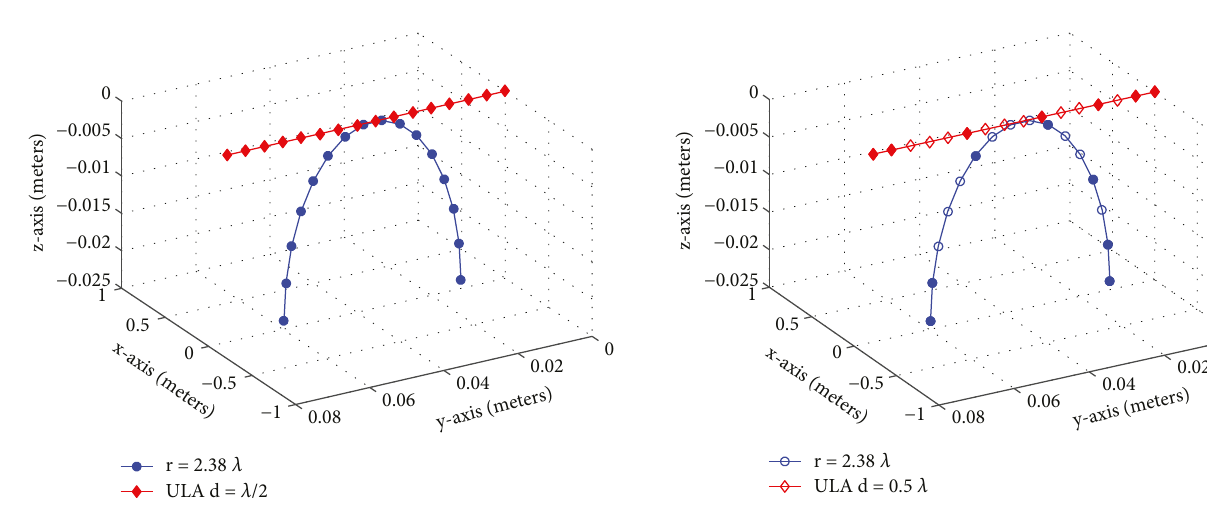
Figure 11: Element positions for the MRA in fl at and wrist- wrapped positions.